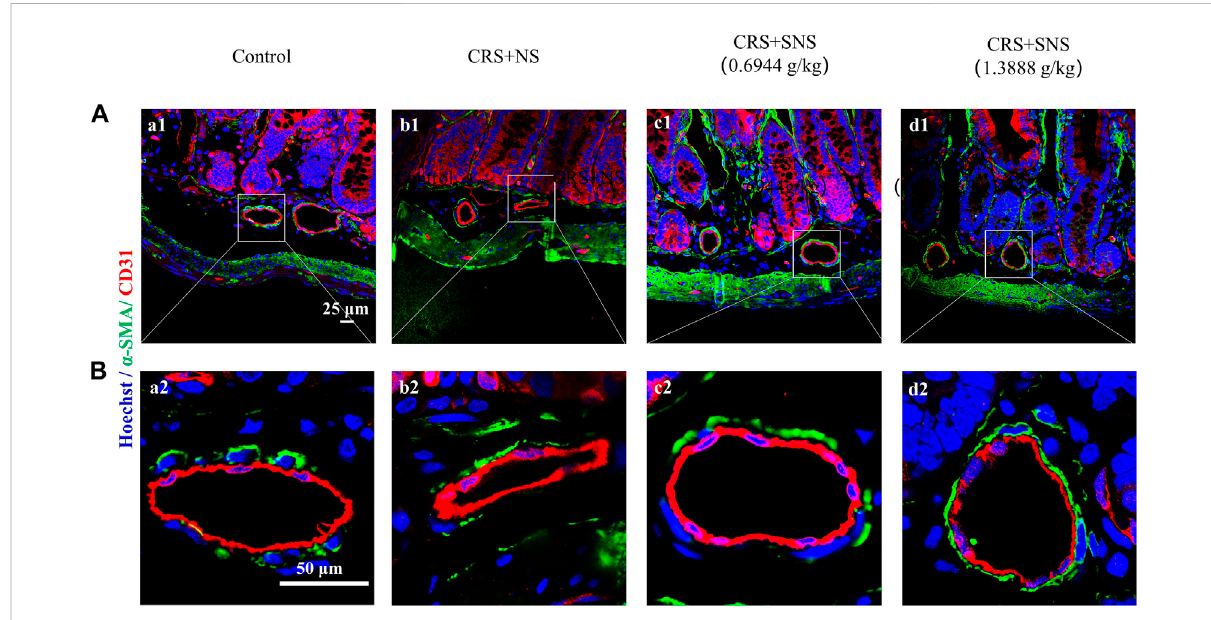
FIGURE 4 Effect of the SNS treatment on the morphological changes of small arteries in the ileum. (A) Representative low magni fi cation of immuno fl uorescent images of small arteries in the ileum in Control (a1), CRS + NS (b1), CRS + SNS (0.6944 g/kg) (c1), CRS + SNS (1.3888 g/kg) (d1), respectively. Bar = 25 μ m. (B) Representative high magni fi cation of the immuno fl uorescent images of small arteries in the ileum in the Control (a2), CRS + NS (b2), CRS + SNS (0.6944 g/kg) (c2), and CRS + SNS (1.3888 g/kg) (d2) groups, respectively. Bar = 50 μ m. The sections were immunochemically stained for α -SMA (green), CD31 (red), and nuclei (blue). (A,B) n =